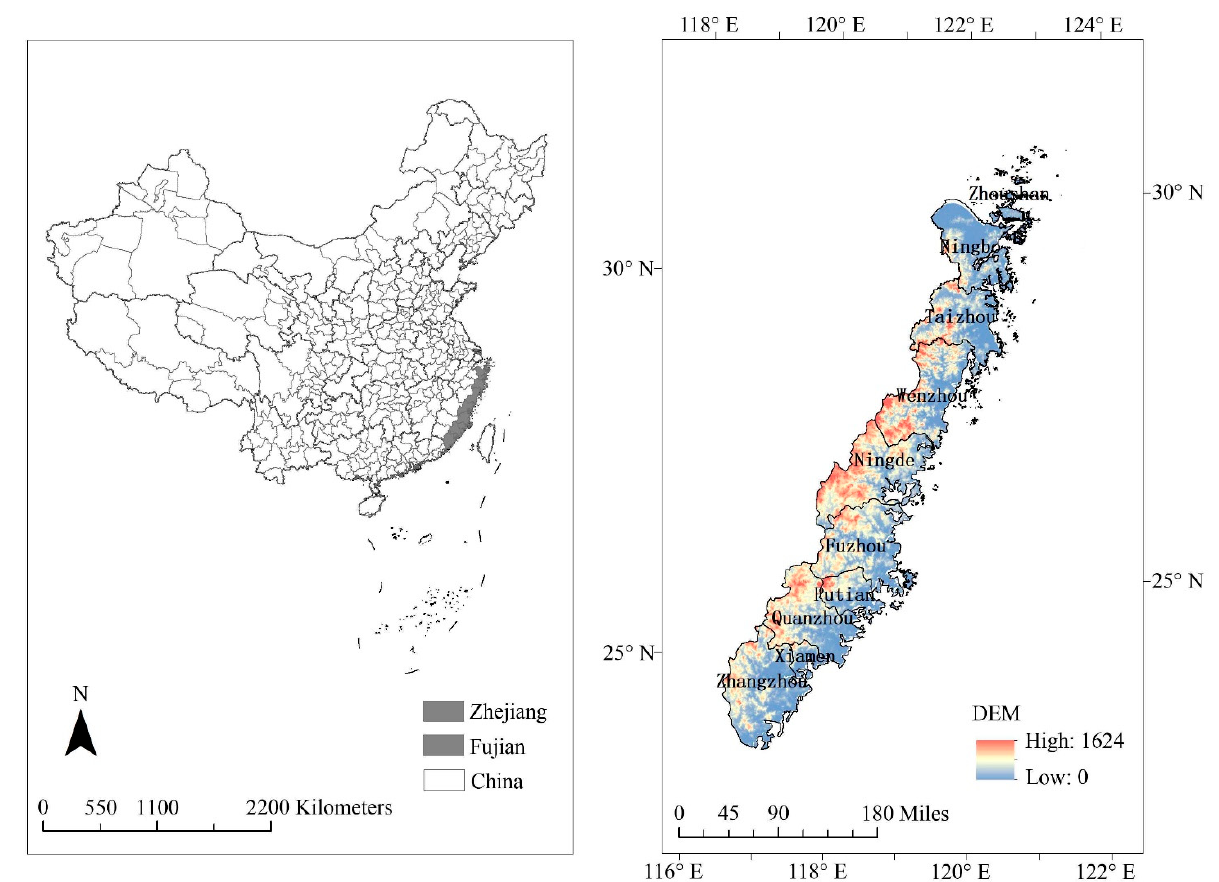
Figure 1. The coastal cities of southeast China.